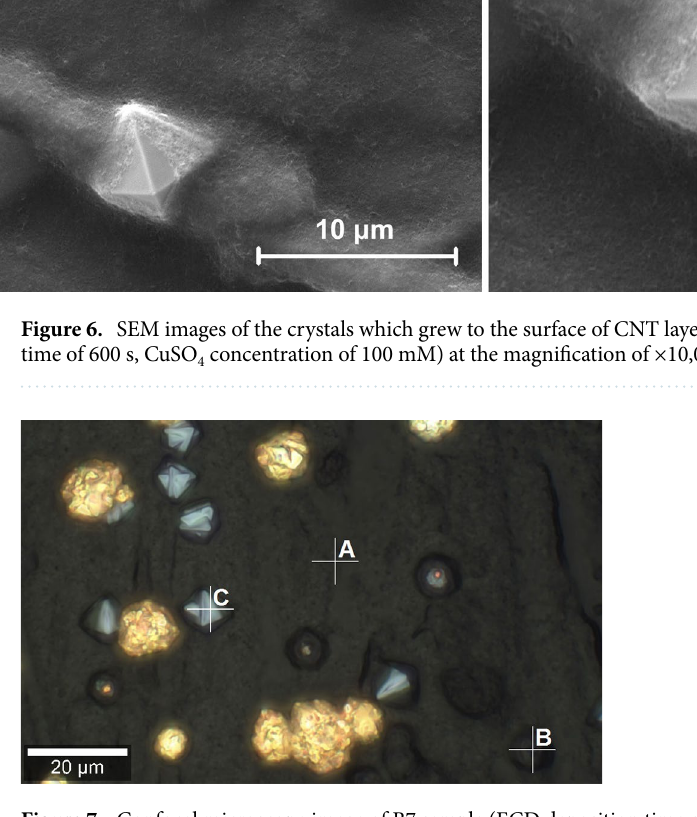
Figure 7. Confocal microscope image of B7 sample (ECD deposition time of 600 s, CuSO 4 concentration of 100 mM) for the single point Raman analysis.